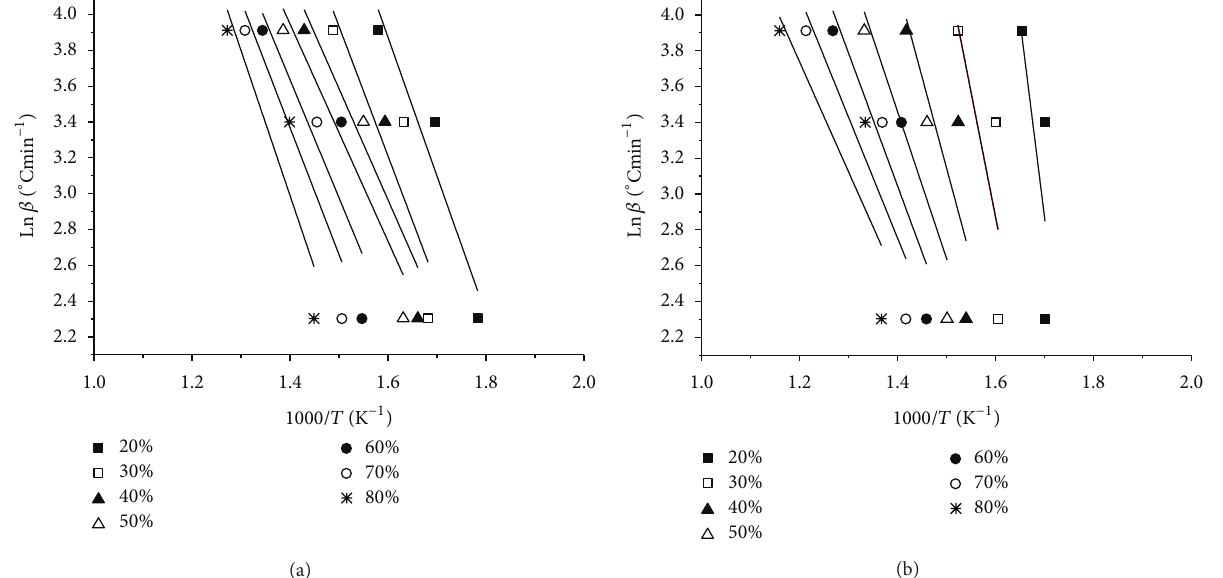
Figure 2: Isoconversional determination of the kinetic parameters based on the FWO method for (a) low CaO and (b) high CaO lignite samples.